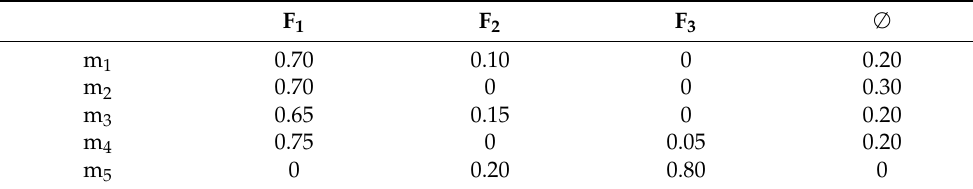
Table 1. Sensor data modeled as BPAs.